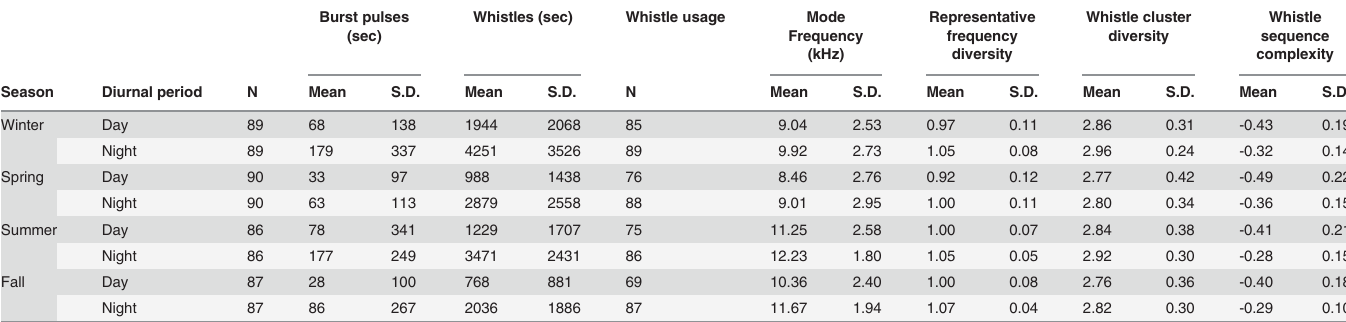
Table 2. The mean and standard deviation on each whistle usage parameter in the two diurnal periods and the four seasons.